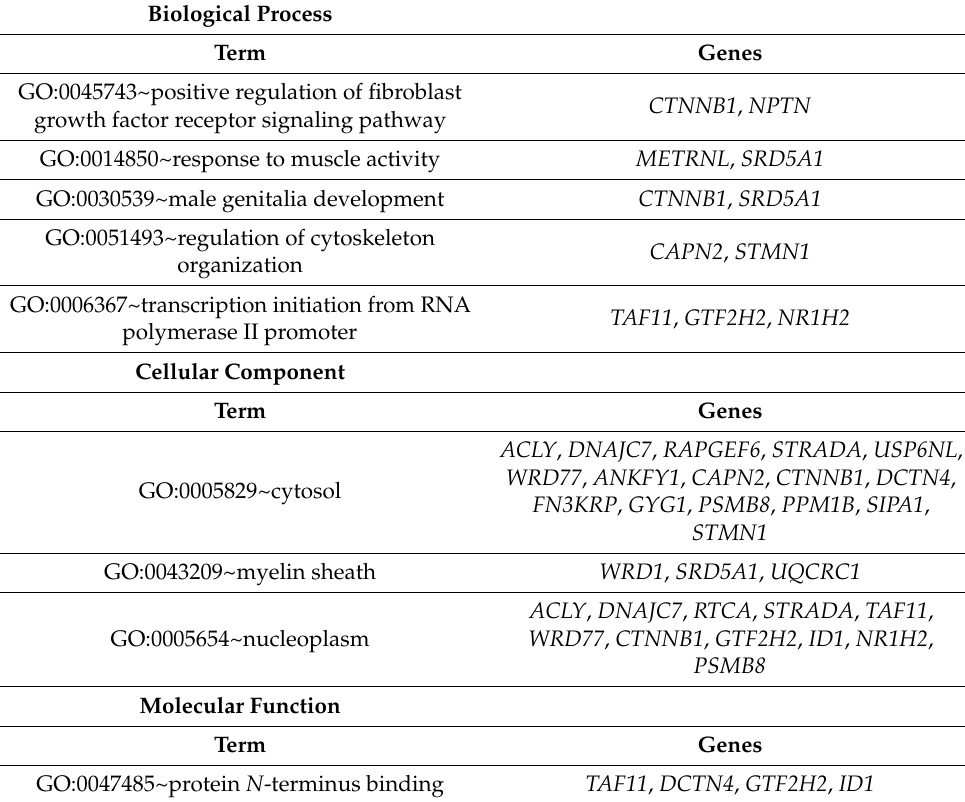
Table 3. Top enriched gene ontology clusters by the upregulated genes analysis by the